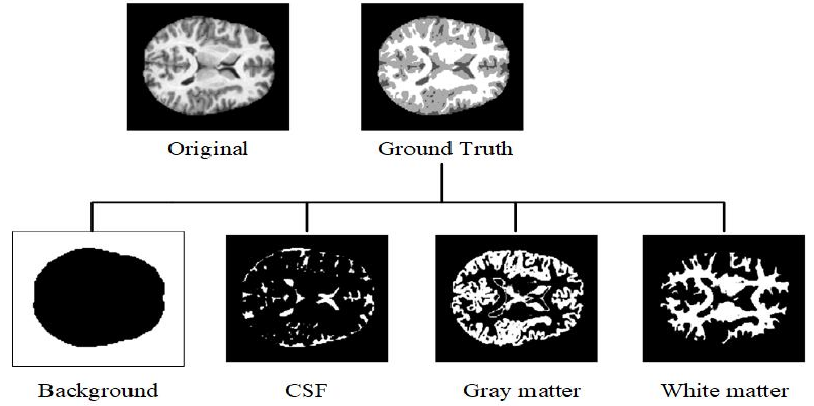
Figure 1. Binary map of four different classes generated from ground truth.